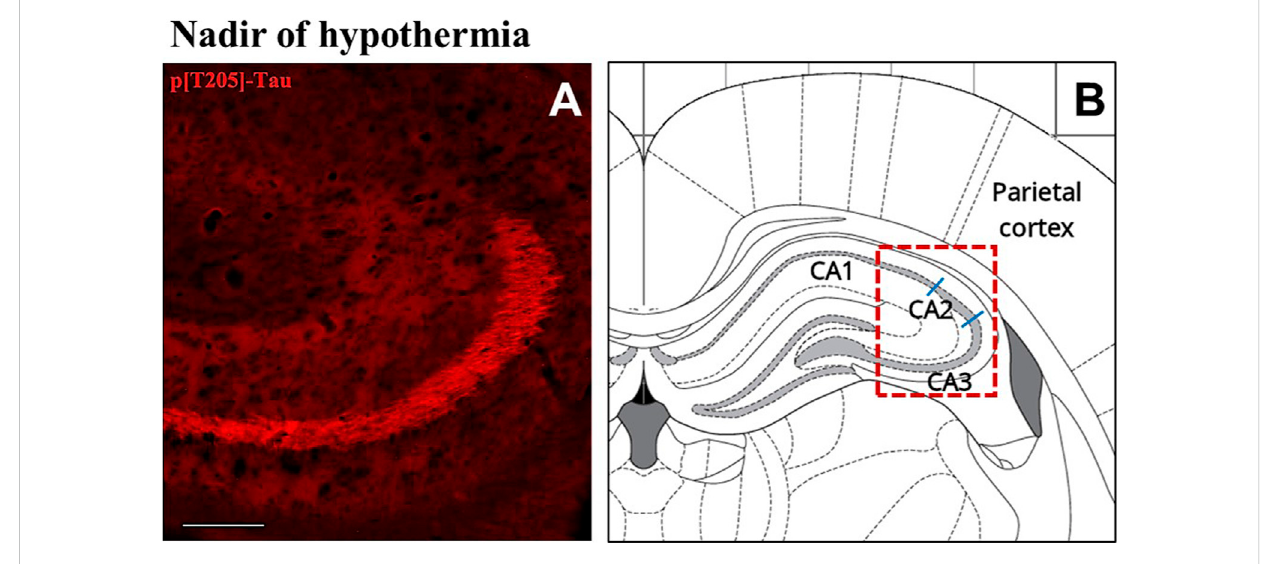
FIGURE 3 Representative pictures showing the hippocampal cortex, speci fi cally stained for p[T205]-Tau, phosphorylated Tau protein in Thr-205 residue (secondaryantibodyconjugatedwithAlexa-594; (A) .In (B) isthecorrespondentlefthippocampalhemicortex fi eld,asrepresentedbytheratbrainatlasat Bregma − 3.12 mm (Paxinos and Watson, 2007). The dashed red line represents the microscope picture shown in (A) and the blue lines represent the boundariesamongthehippocampal cortical fi elds(PaxinosandWatson,2007). (A) showsthat p[T205]-Tauimmunostainingwaspositive intheonly CA3area, while CA1and CA2 areasare not stained. The picturerefers to theN condition (samples taken atthenadir ofhypothermia, during theinduction of synthetic torpor; see Figure 1). Calibration bar: 100 μ